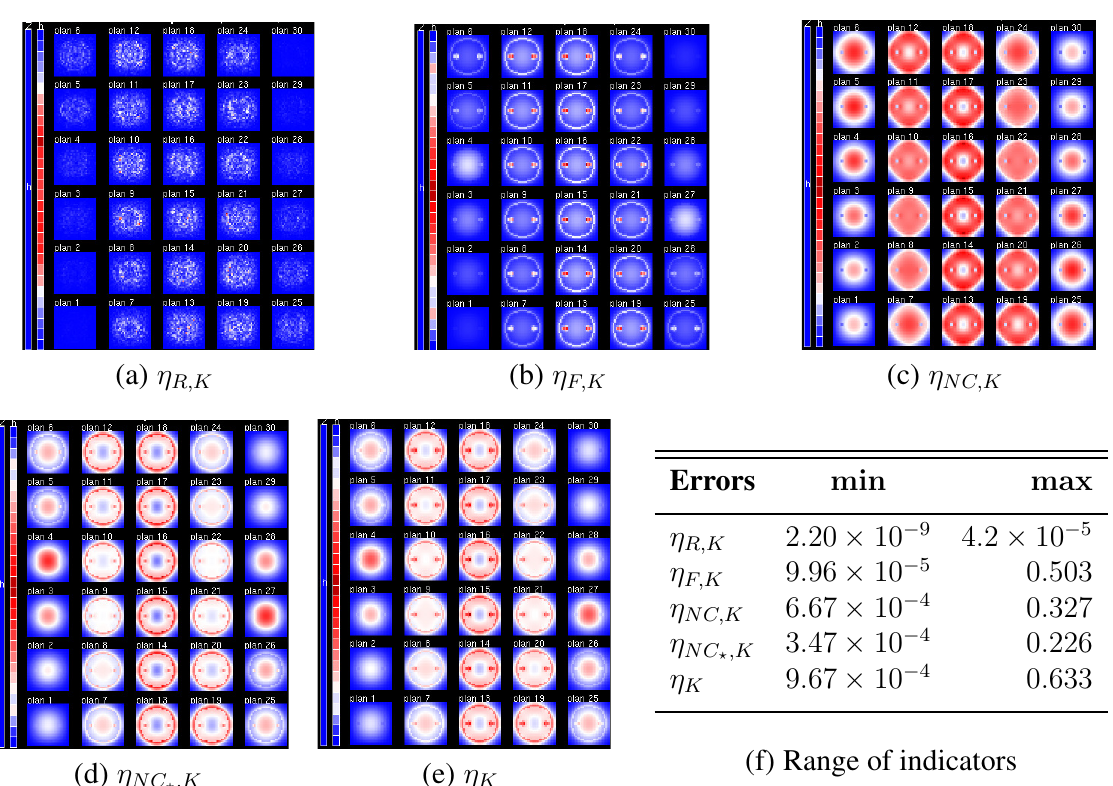
Figure 2: Error indicators with RT